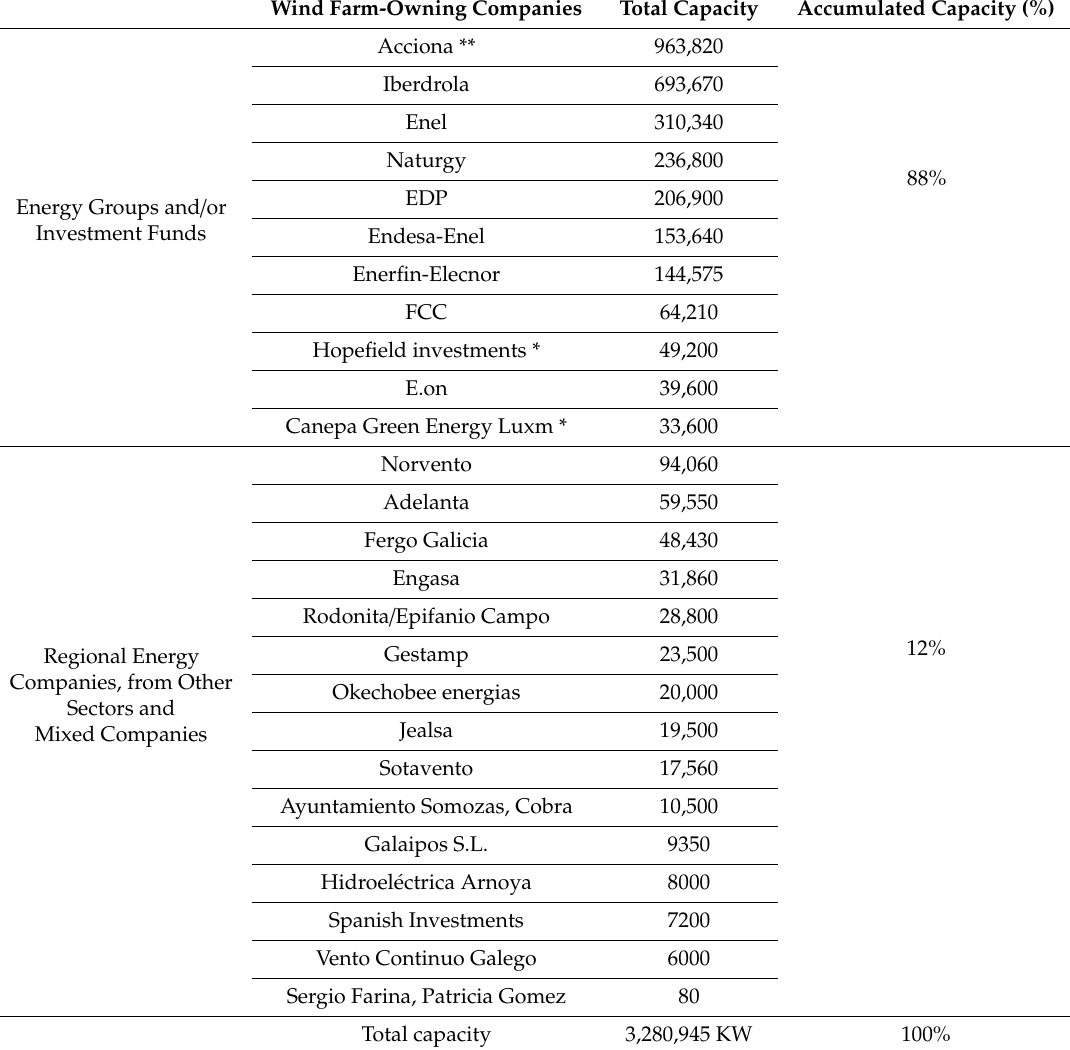
Table 4. Ranking of matrix companies involved in authorized wind farms in Galicia (1995–2017) elaborated from